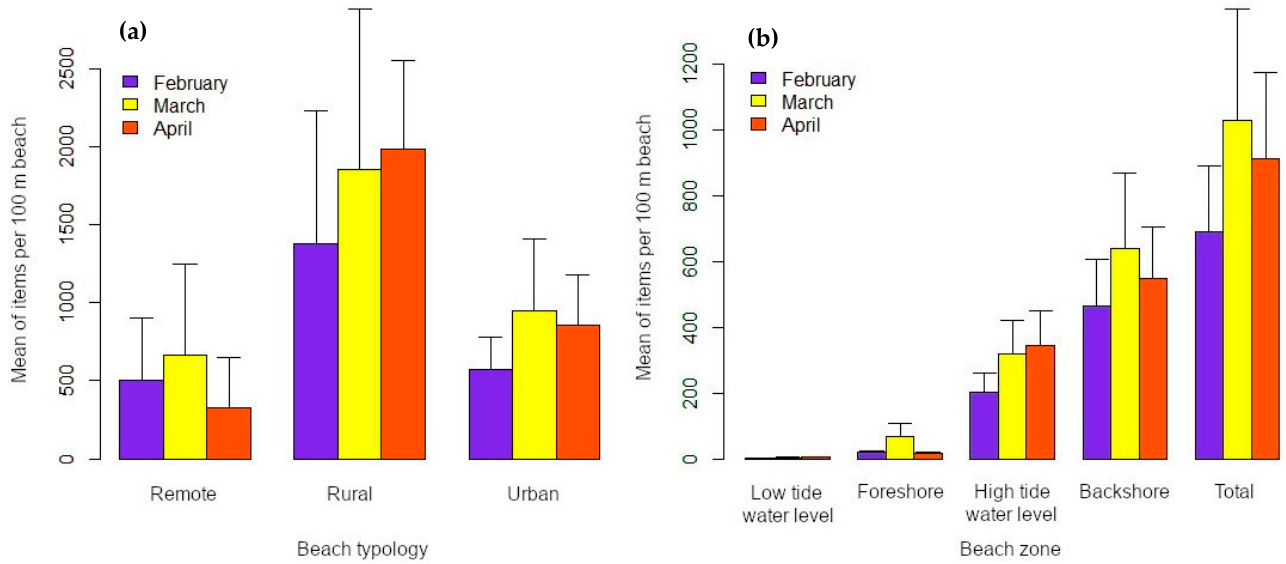
Figure 5. Interaction plots: ( a ) abundance of litter by beach typology for February, March and April; ( b ) abundance of litter by beach zone for February, March and April.